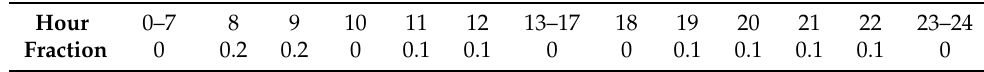
Table 2. DHW profile assumed in the